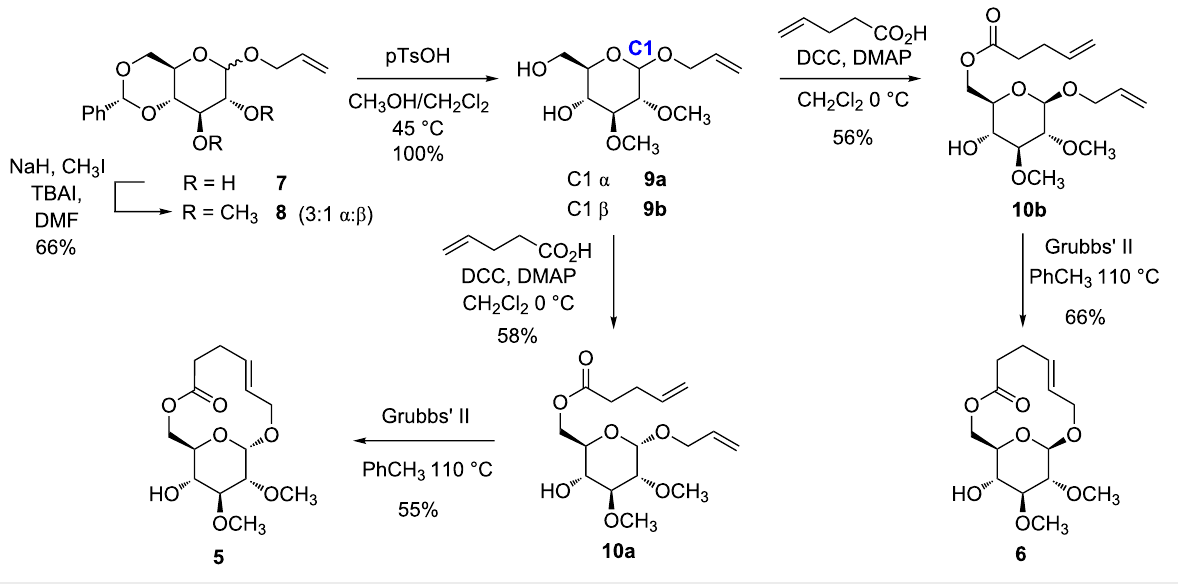
Scheme 1: Synthesis of macrolides 5 and 6 by a ring closing metathesis